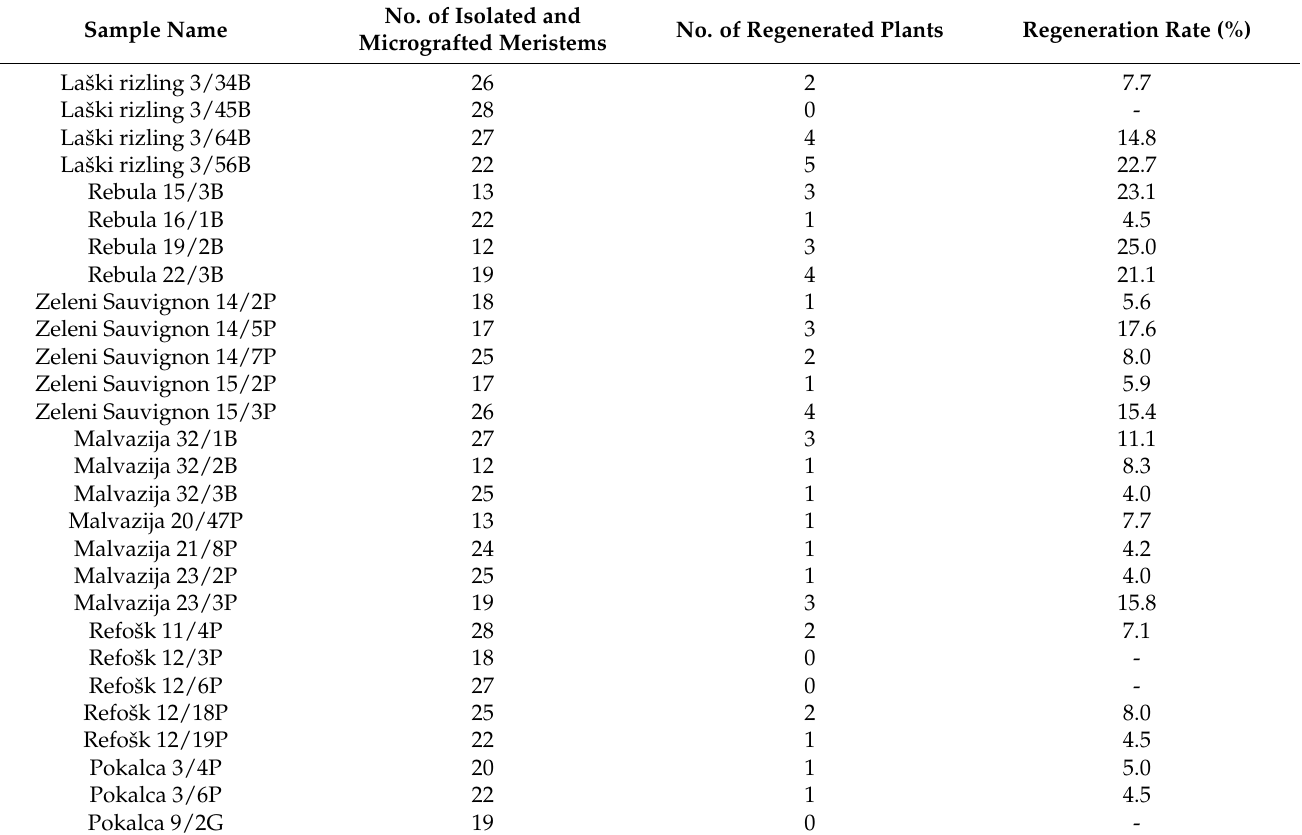
Table 1. Number of isolated and micrografted meristems, number of regenerated plants, and regener- ation rate (%) per individual preclonal candidate of grapevine varieties ( Vitis vinifera